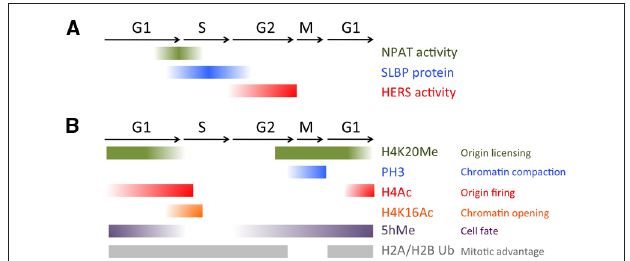
FIGURE 2 | Chromatin modifications and histone biogenesis regulators during the cell cycle . (A) Factors controlling histone biogenesis are regulated by the cell cycle to limit histone biogenesis to S-phase. (B) Chromatin modifications, including histone PTMs and 5-hydroxy-methylcytosine (5hMe) occur in a cell cycle regulated manner to impact gene expression and nuclear